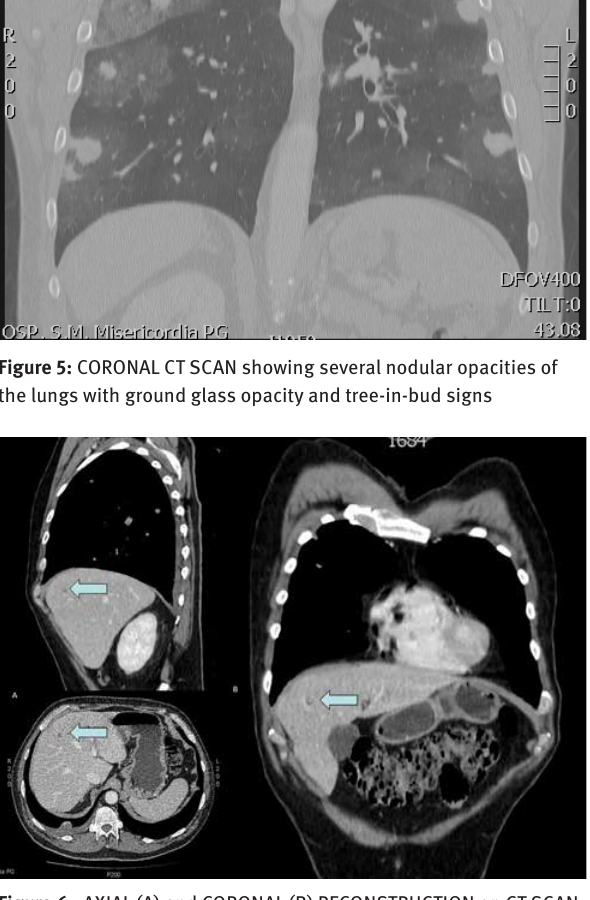
Figure 6: AXIAL (A) and CORONAL (B) RECONSTRUCTION on CT SCAN showing multiples hypodense liver lesions. The arrow point the biggest one of almost 10 mm of